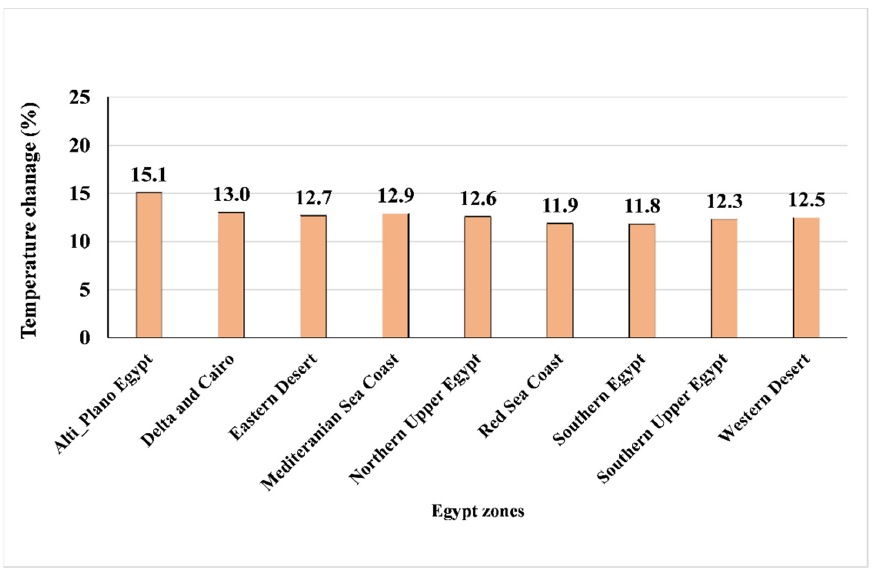
Figure 7. The zonal temperature changes in Egypt between the past period (1950–2014) and the future period (2015–2099). future period